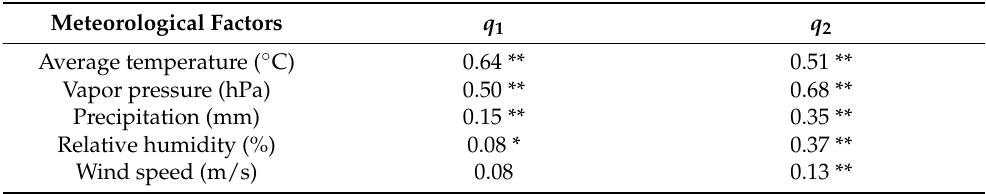
Table 1. The q values ( q 1 , q 2 ) for the association between PM 2.5 concentrations and meteorological factors in Northern and Southern China,